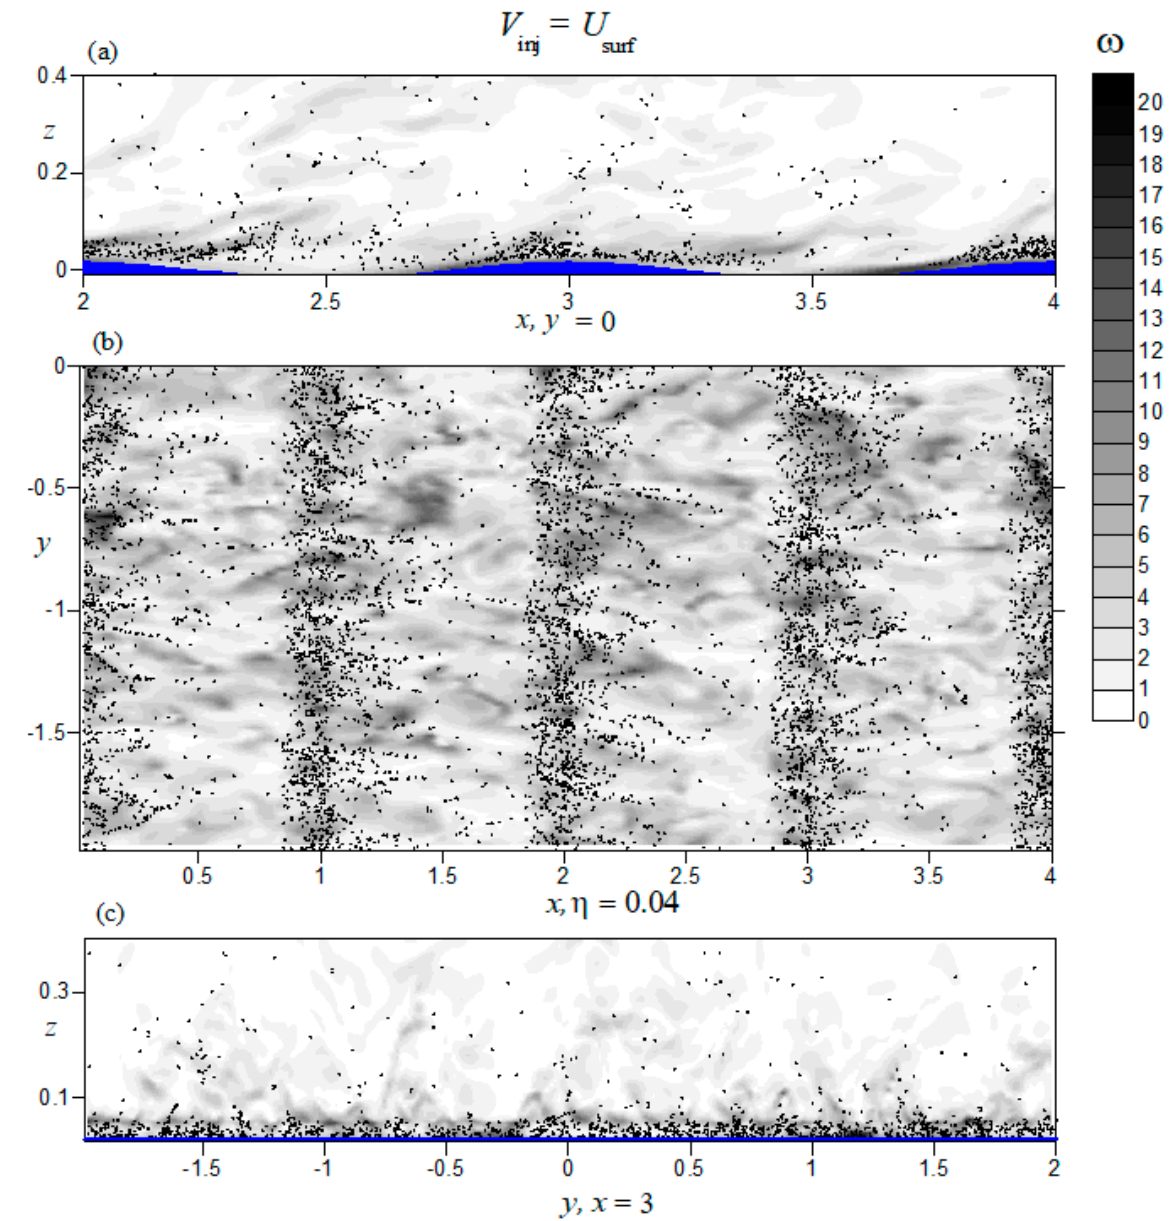
V U = . Droplets are inj surf